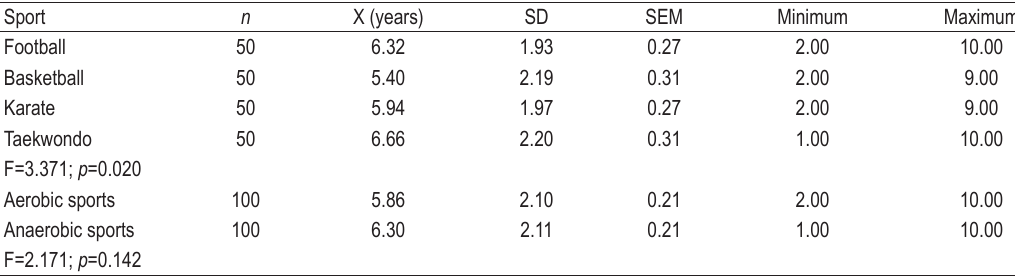
TABLE 3. The average duration of active training Sport